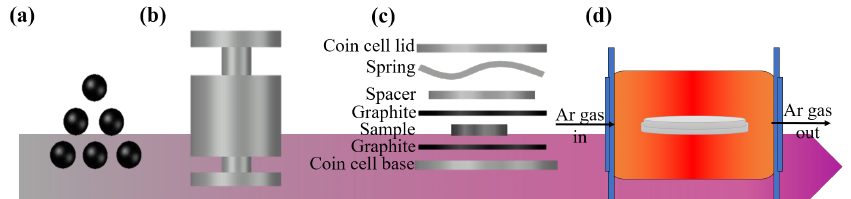
Figure 1. Schematic of experimental process: ( a ) powder grinding and sieving (45–53 µm); ( b ) cold pressing; ( c ) coin cell canning package; and ( d ) annealing